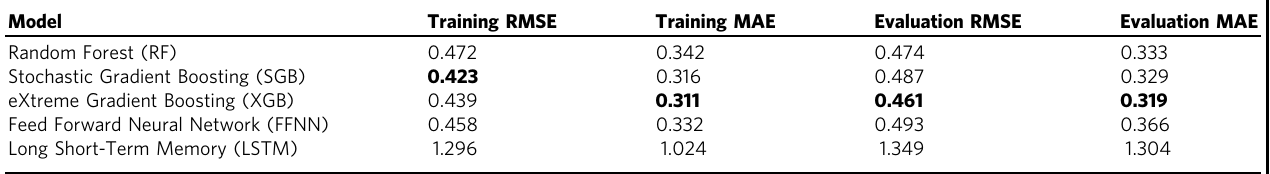
Table 1 Performance comparison of machine learning